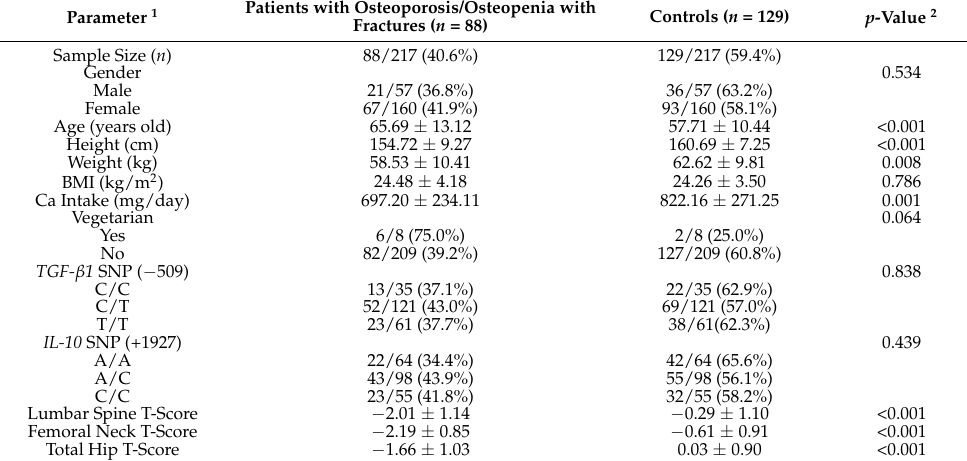
Table 2. Clinical characteristics of patients with osteoporosis or osteopenia with fractures and healthy